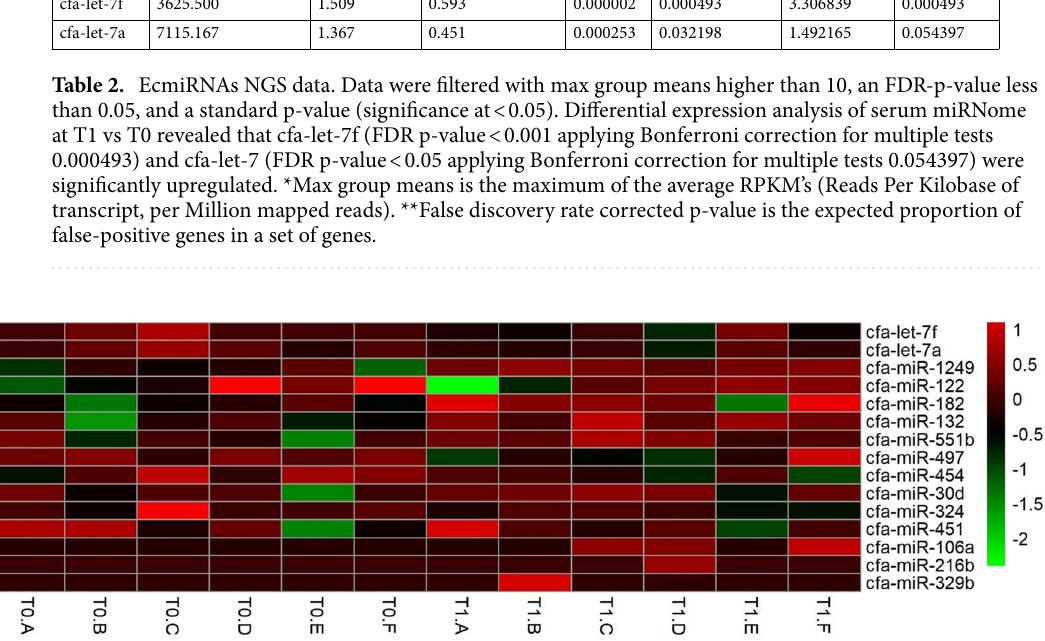
Figure 3. Volcano plot. The figure shows the relationship between the magnitude of the difference in expression values (fold change) and statistical p-values. The lower difference in expression, the nearer the point will be to the x-axis. The more significant the difference, the smaller the p-value, and the higher -log 10 p-value. Thus, points for features with highly significant differences will lie high in the plot. The cfa-let-7f (0.000002 p-value) and cfa-let-7a in the plot (red) represent the differentially expressed ecmiRNAs with statistical significance (0.000253 p-value).